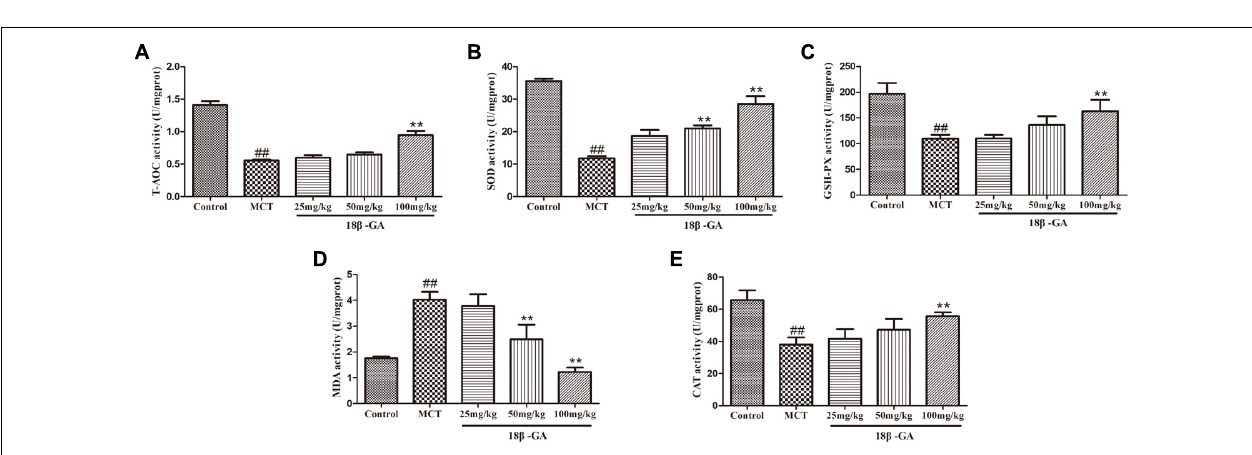
FIGURE 7 | Ultrathin cross-sections of the pulmonary vascular in rats were examined under transmission electron microscopy (6,000 × magnification; bar = 5,000 nm). (A) Control group; (B) MCT group; (C) 18 β -GA 25 mg/kg group; (D) 18 β -GA 50 mg/kg group; (E) 18 β -GA 100 mg/kg group; (F) Sildenafil 30 mg/kg group. Endothelial cell (thick arrow), smooth muscle cell (thin arrow), and elastic membrane (arrow head). MCT, monocrotaline; 18 β -GA, 18 β -glycyrrhetinic acid.